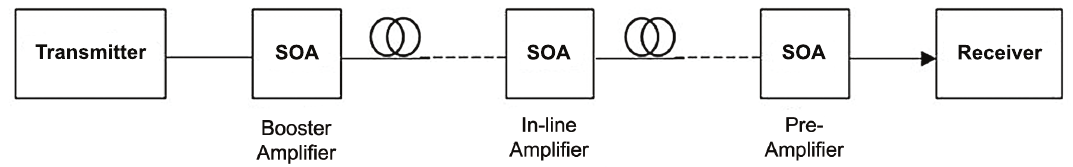
Figure 1. SOA direct amplification